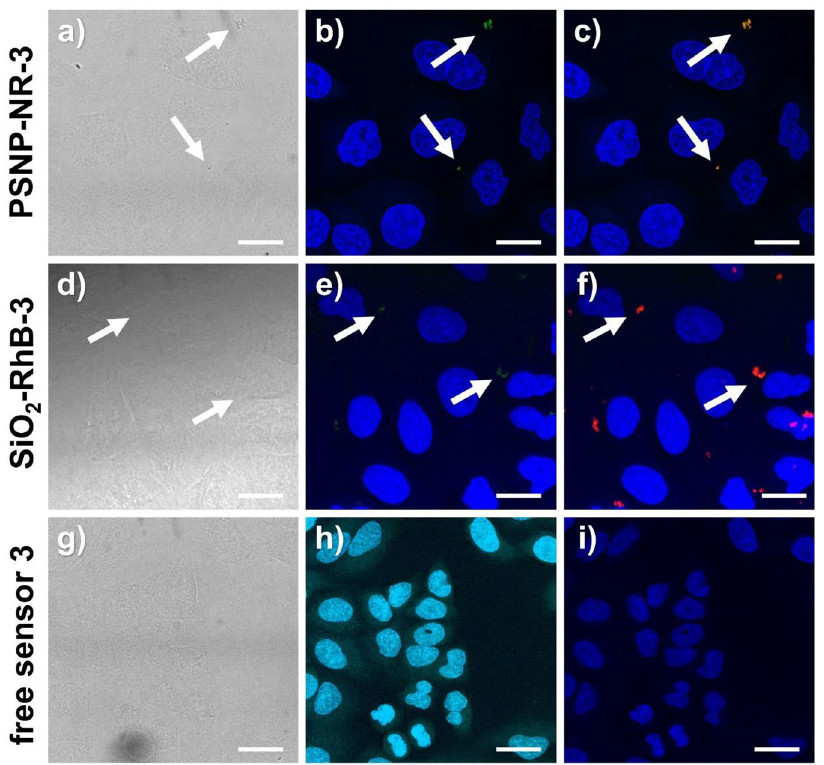
Figure 9. CLSM images of the fixed A549 cells (PFA) that were previously incubated with PSNP-NR- 3 ( a – c , particle concentration 100 µg/mL), SiO 2 -RhB- 3 ( d – f , particle concentration 100 µg/mL), and 3 ( g – I , dye concentration 35 µg/mL) for 30 min at a pH 4.5 in the presence of the H + /K + ionophore nigericin. The nuclei were stained with DAPI. Transmitted light ( a , d , g ); merged blue (DAPI) and green (pH probe 3 ) channels: ( b , e , h ); and merged blue (DAPI), green (pH probe 3 ) and red (reference dyes, NR or RhB) channels: ( c , f , i ). The following measurements conditions were used: λ Ex = 405 nm, λ Em1 = 420-480 nm and λ Em2 = 520–560 nm for DAPI and 3 , and λ Ex = 560 nm and λ Em = 570-660 nm for the red reference dyes. All images show a scale bar of 10